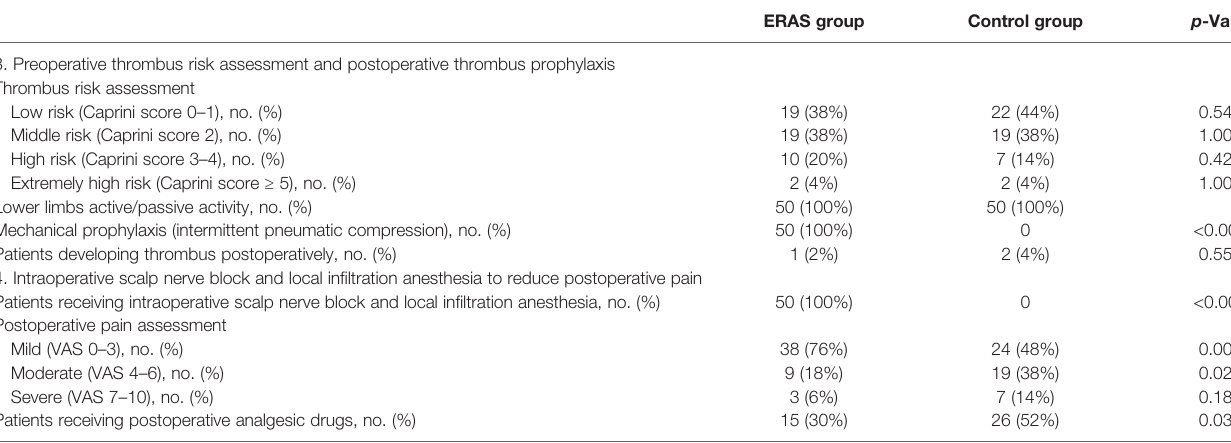
TABLE 4 | The second part of ERAS measures and